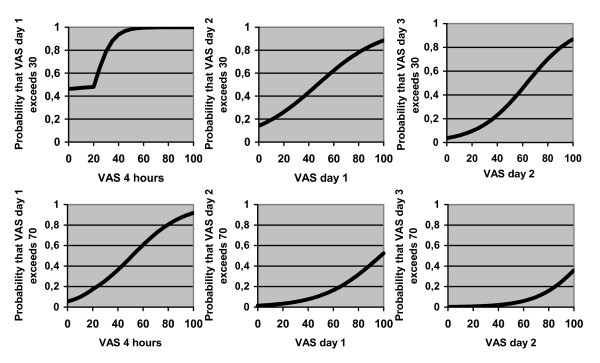
The figures show the probability that VAS exceeds 30 mm and 70 mm days one, two and three depending on previous VAS values. If e.g. the VAS value is 40 after four hours, the probability that VAS exceeds 30 mm day one is 95% and the probability that VAS exceeds 70 mm is 40%.